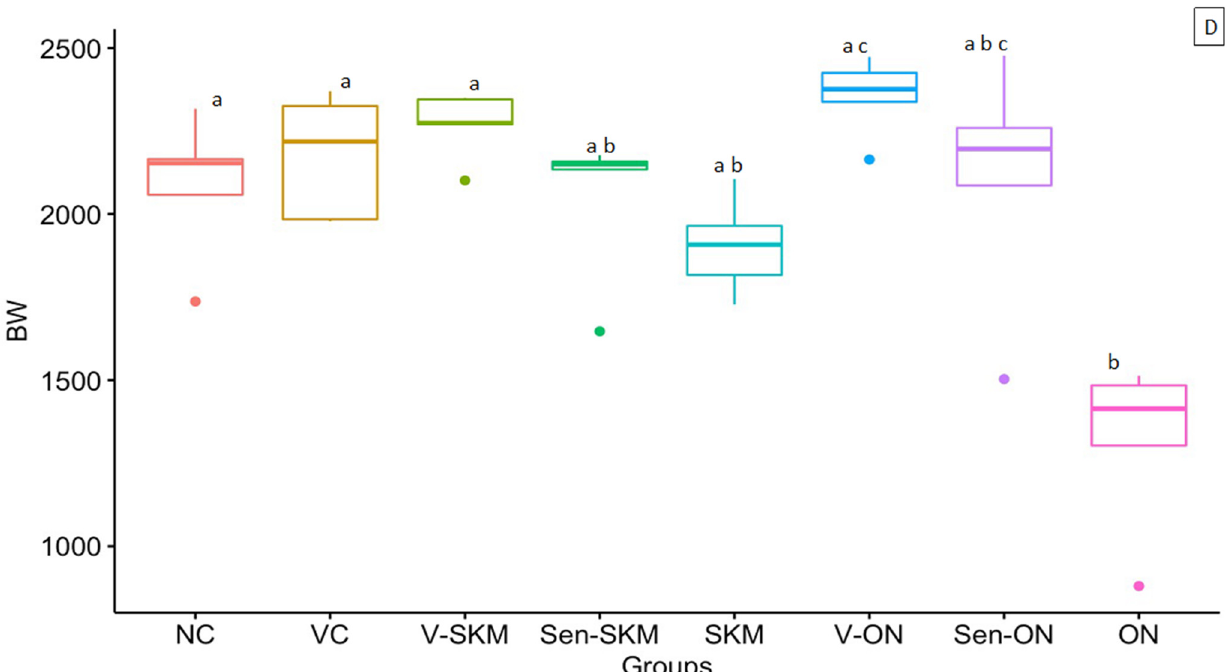
Figure 1. ( A ) SN Ab titer of the vaccinated and sentinel birds against the homologous TARV SKM121 virus; ( B ) SN Ab titer of the vaccinated and sentinel birds against TARV O’Neil virus; ( C ) BW of birds from respective groups at 28 doa; ( D ) BW of birds from respective groups at 35 doa. Box plots with different letters have significant differences at p < 0.05.